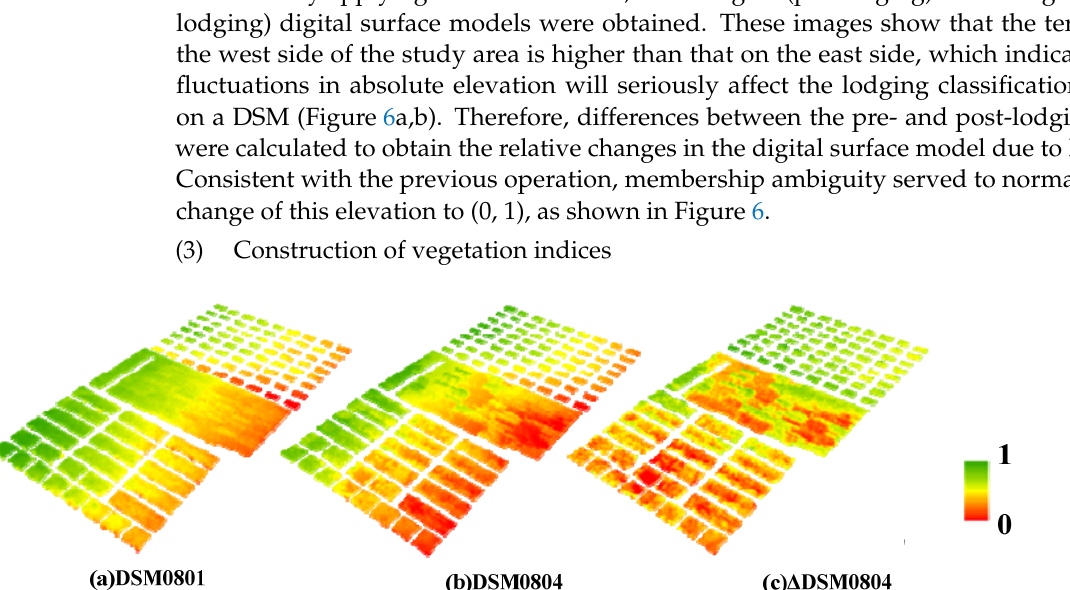
Table 4. Characteristic bands or vegetation indices used in this experiment.